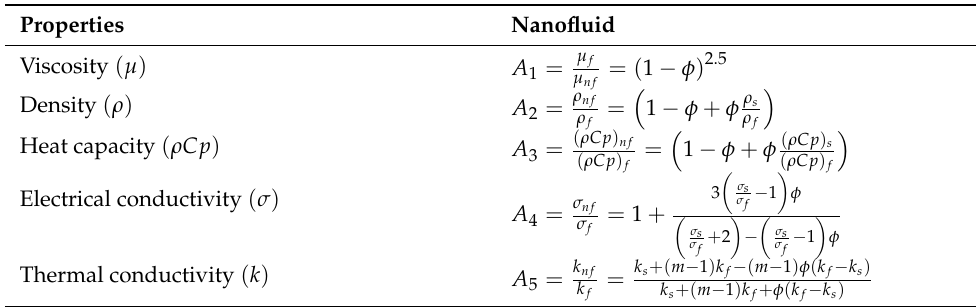
Table 2. Physical characteristics, see Sharma